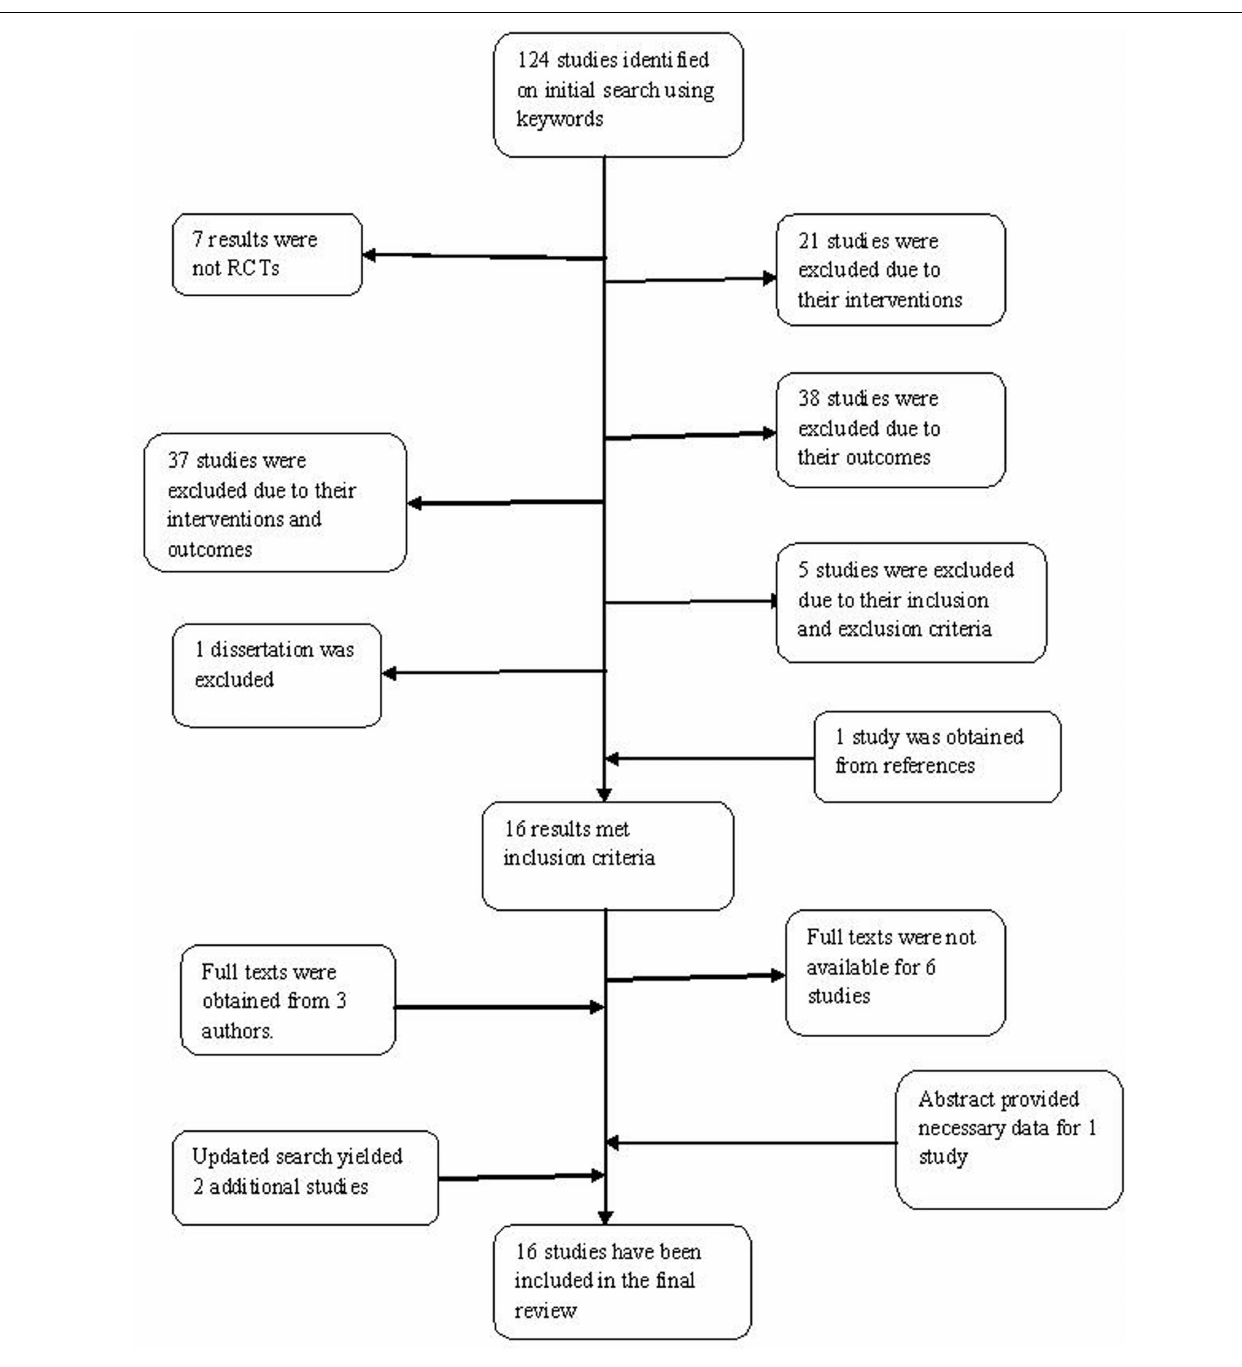
FIGURE 2 | Literature